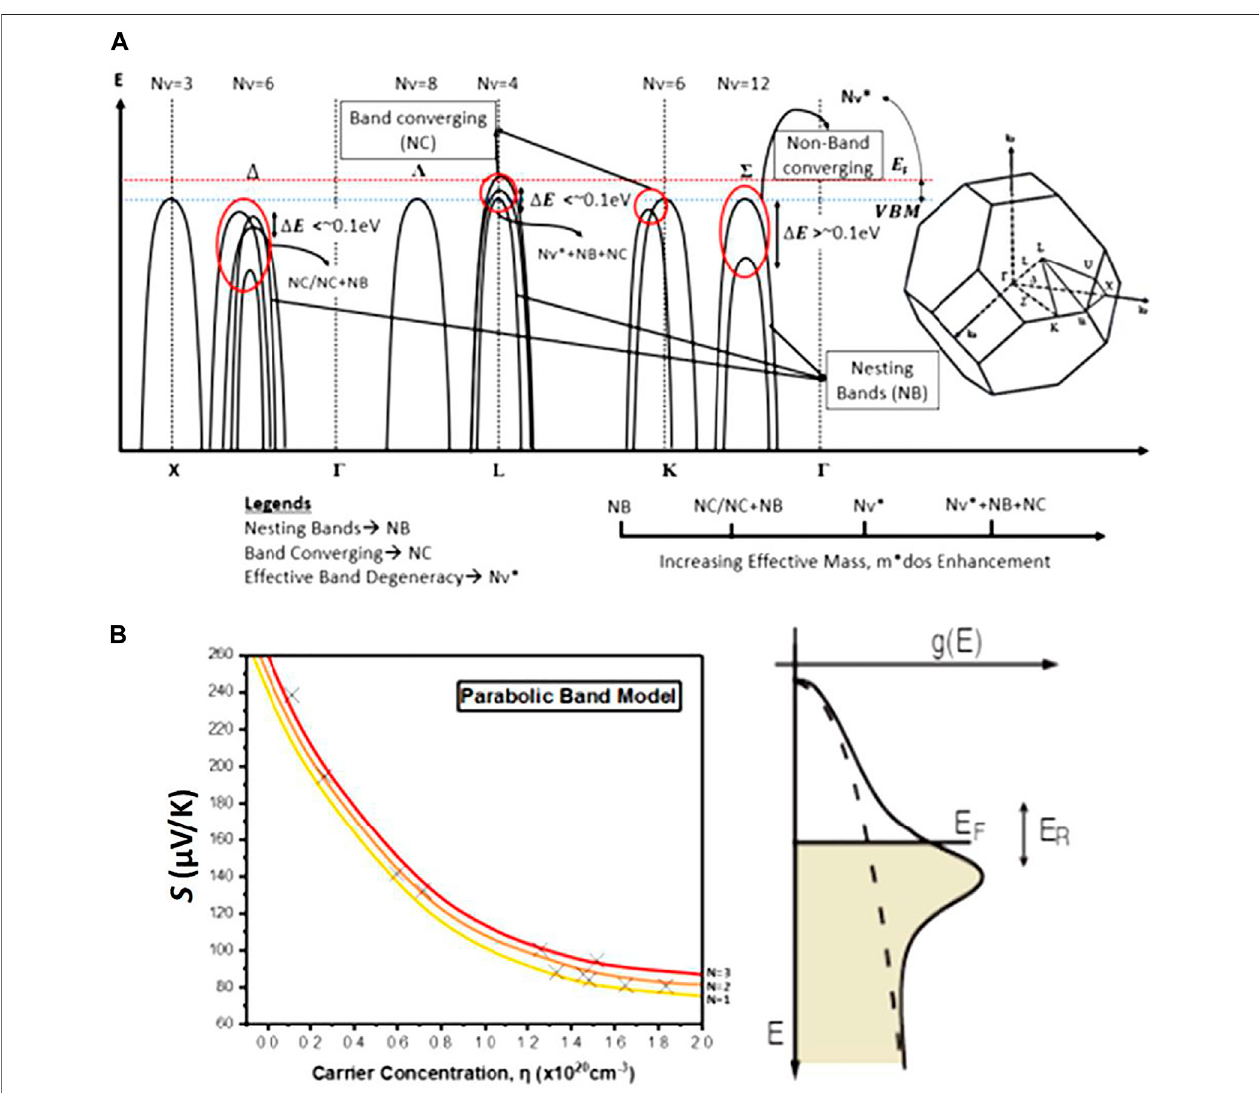
FIGURE 2 | (A) An illustration of the band structure consisting of examples of converging, non-converging, and nesting bands, and the Brillouin zone of face- centered cubic (FCC) lattice. (B) An illustration of the Pisarenko plot based on single parabolic band (SPB) model calculations with a density of states (DOS) pro fi le of 3D bulk material relative to